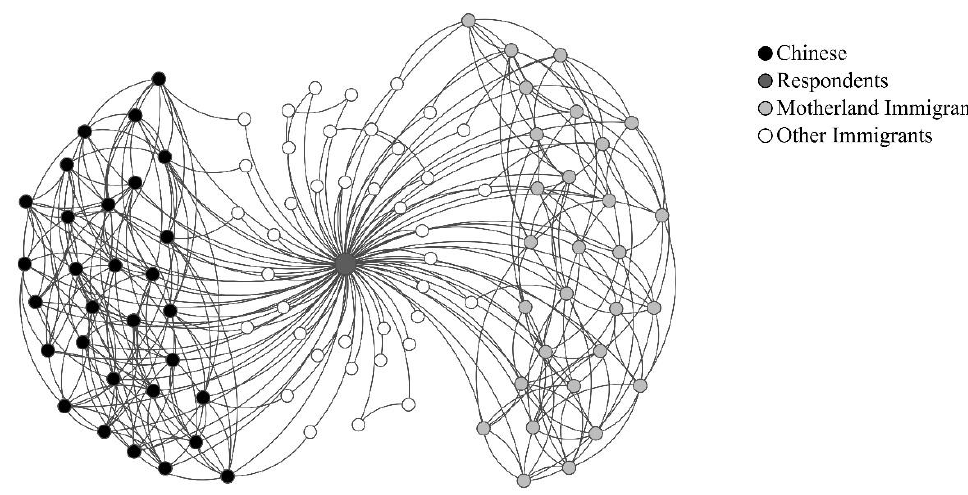
Figure 1. The ideal network structure for a foreigner in